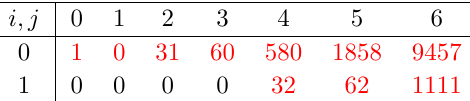
for the unre(cid:12)ned elliptic genus of three SO(8) instanton